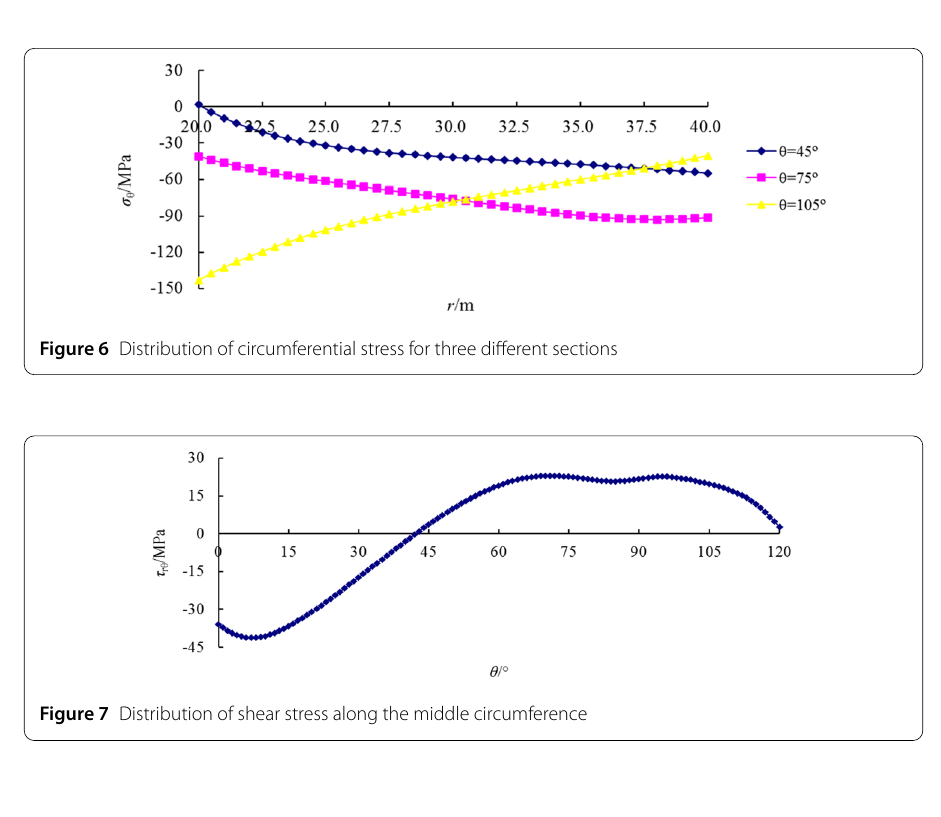
for θ = 75 ◦ is 40.99 MPa on the inner surface, while the value is 91.28 MPa on the